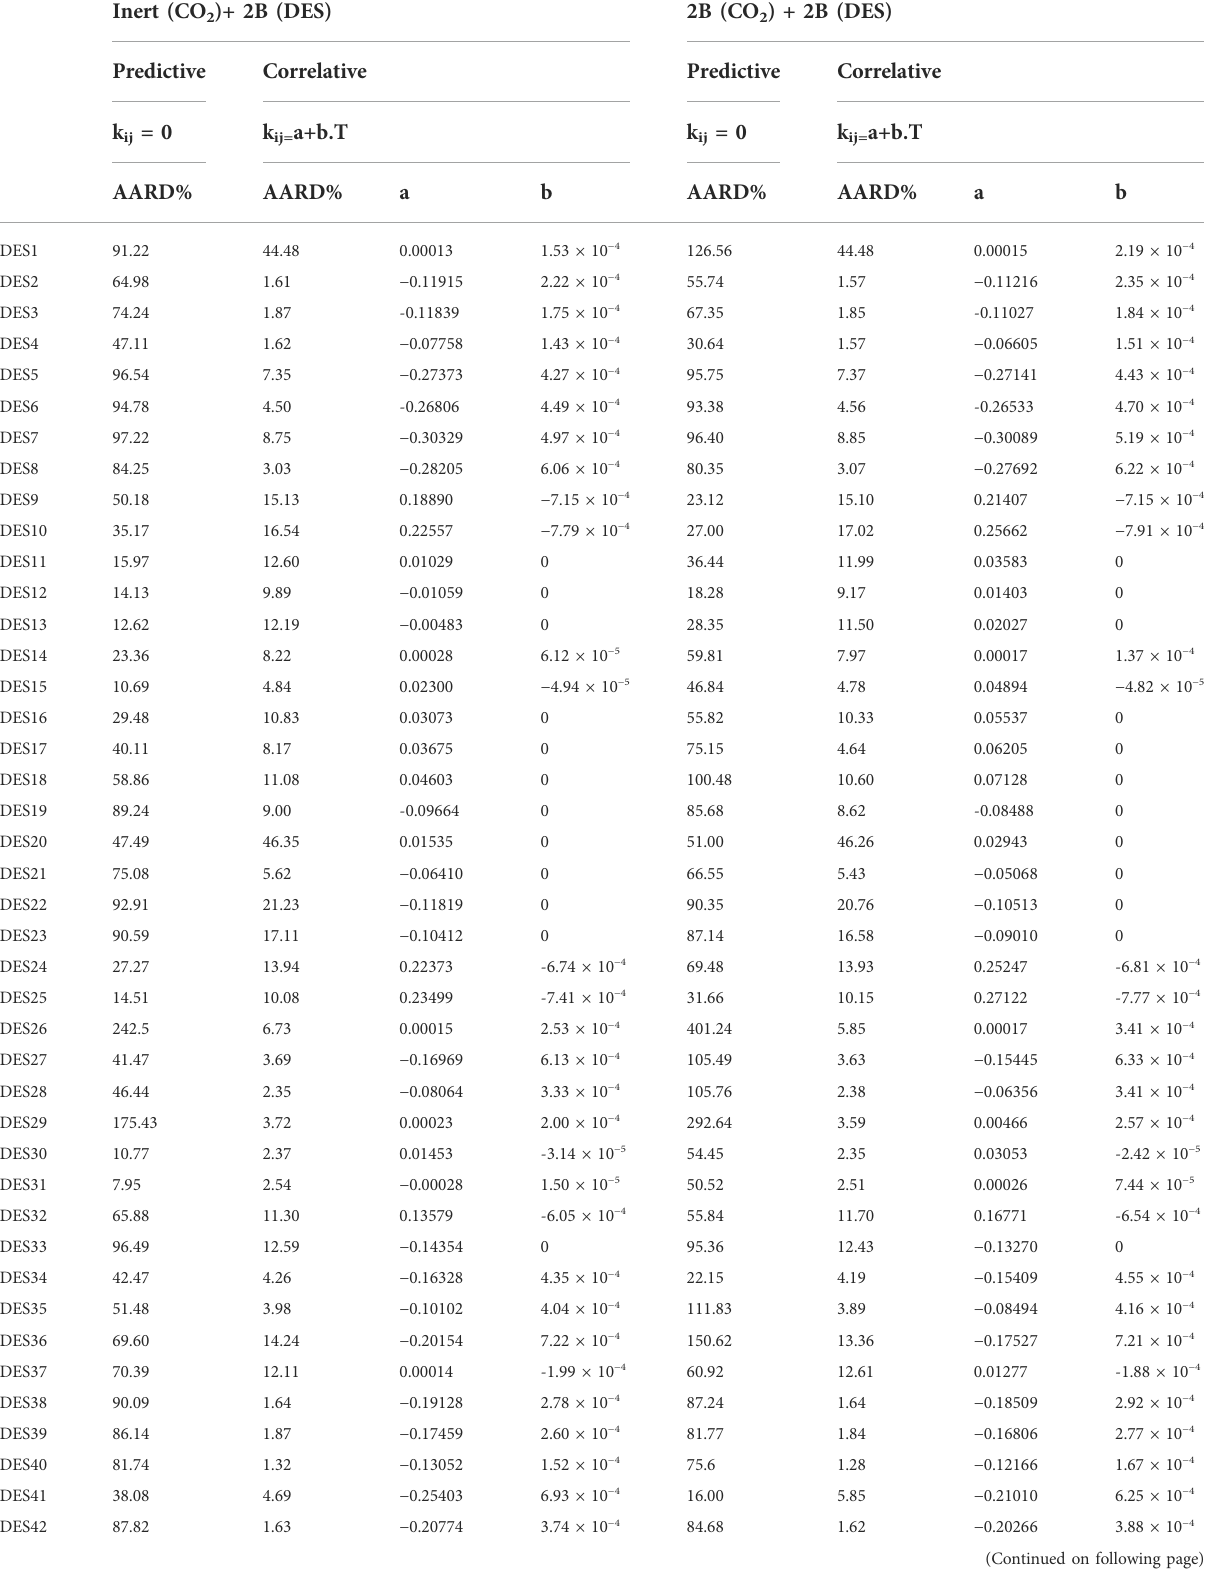
TABLE2Thevaluesofoptimizedparametersand AARD% forthetwopredictiveandcorrelativemodesofPC-SAFTEoSbyconsideringtwoassociation schemes for CO 2